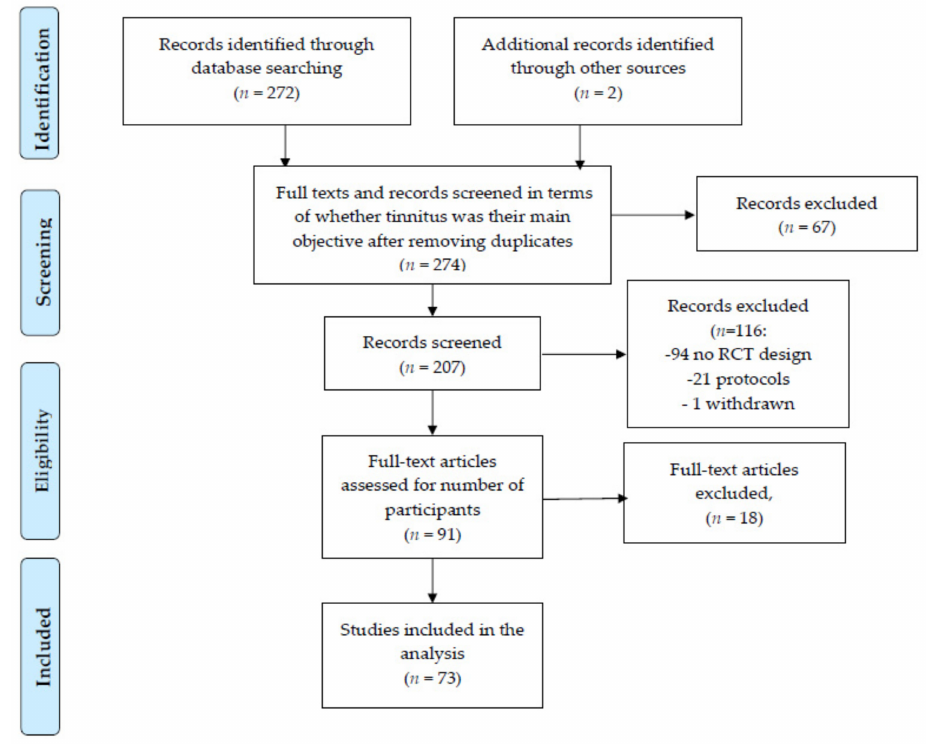
Figure 1. Study selection PRISMA flow